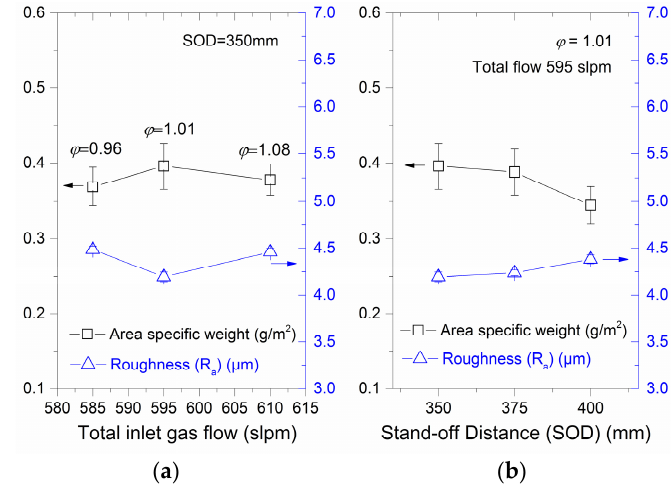
Figure 2. ASW and roughness of the HVOF sprayed Yb 2 Si 2 O 7 coatings as a function of the total inlet gas flow ( a ) and ( b ) the stand ‐ off distance. Error bars of the ASW values calculated from the standard deviation of four substrate area measurements and error bars of the roughness show the standard deviation of 10 profile measurements ( λ c = 2.5 mm).